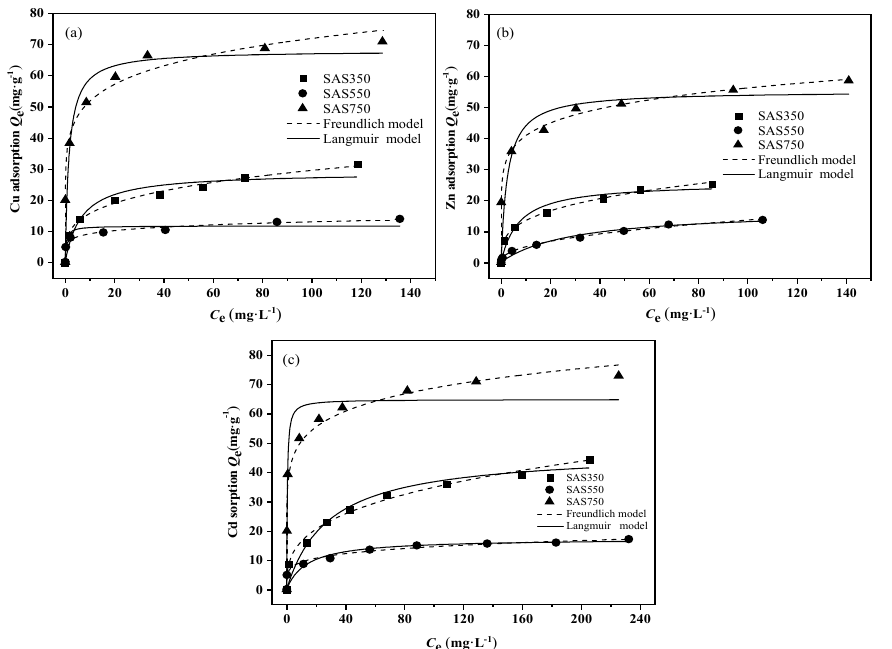
Figure 4. Isotherm model of sorption of Cu(II) ( a ), Zn(II), ( b ) and Cd(II) ( c ) on biochars at 350, 550, and 750 °C.